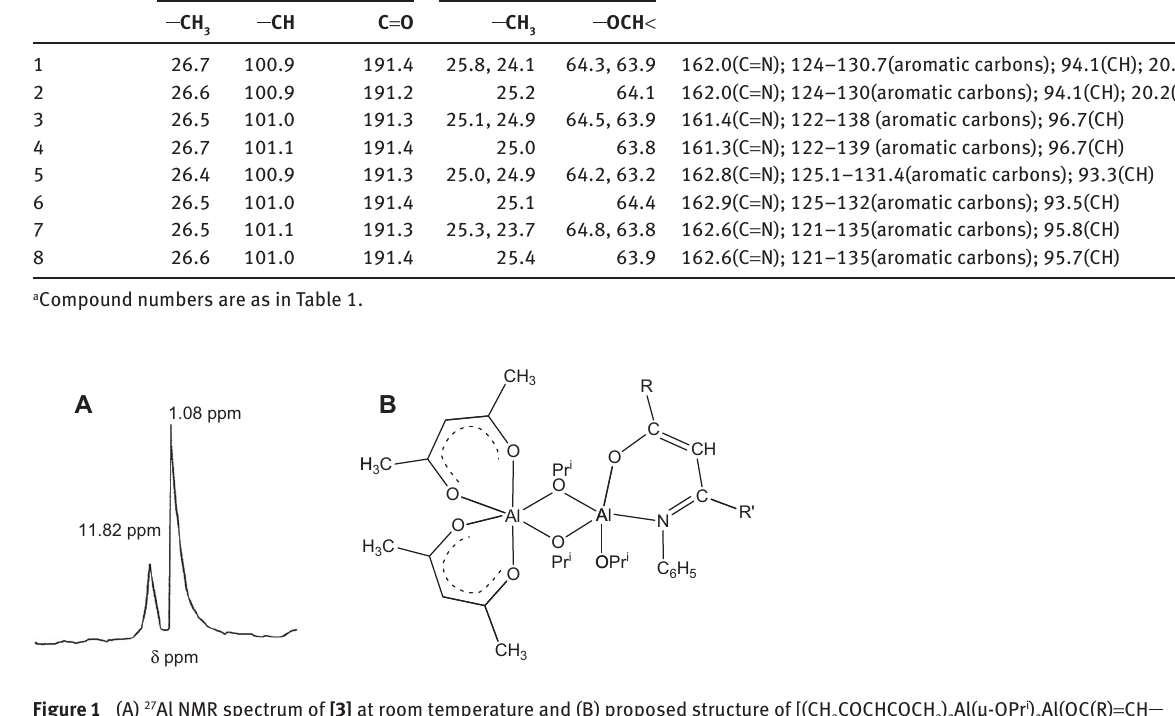
H )(OPr i ) (where R = R ′ = CH 6 5